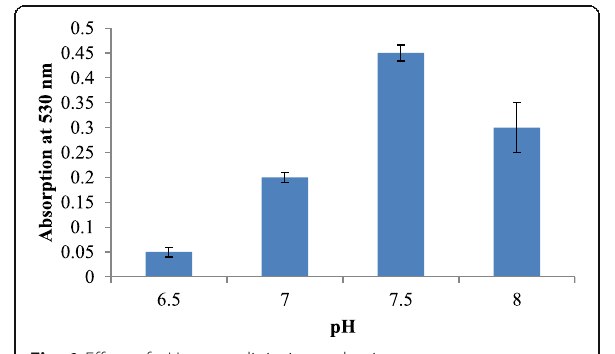
Fig. 1 Effect of pH on prodigiosin production